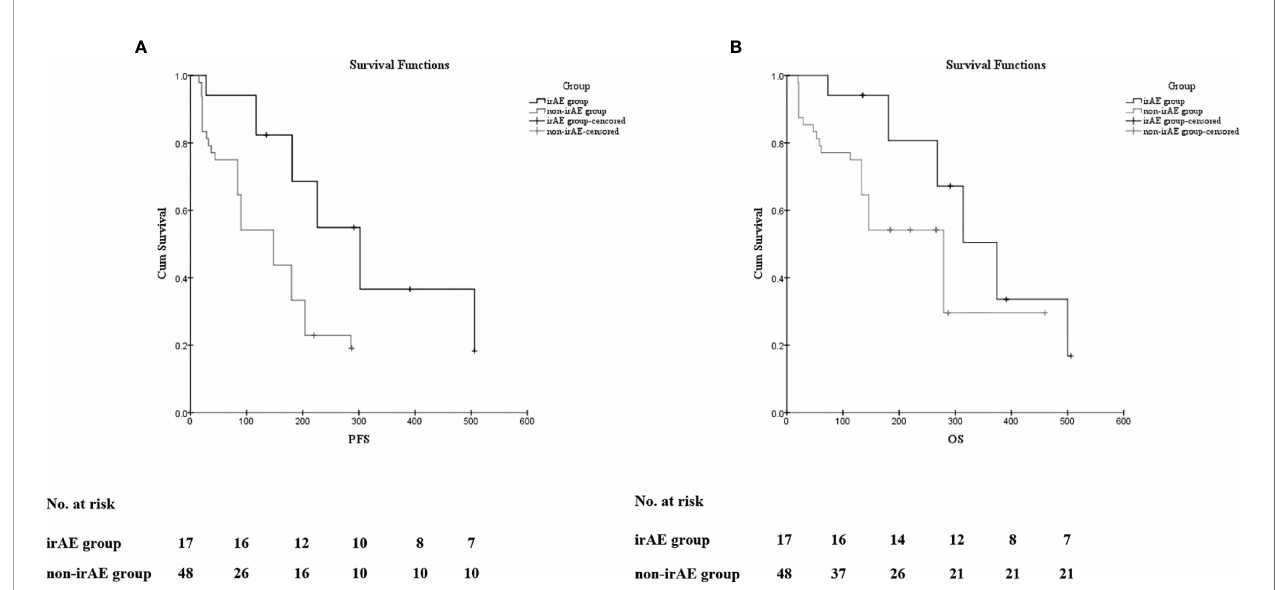
FIGURE 1 | The association of irAEs on the prognosis of HCC patients. (A) The Kaplan – Meier curve of progression-free survival (PFS). (B) The Kaplan – Meier curve of overall survival (OS).